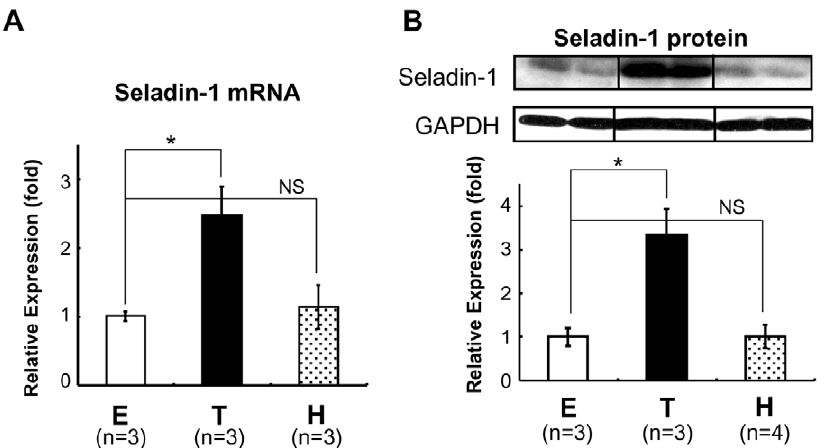
Figure 1. TH induced Seladin-1 mRNA and protein expression in the mouse forebrain. C57/B6 mice (8- to 12-week-old males) were rendered hypothyroid (H) with MMI and PTU diet or treated with T 3 (T). E: euthyroid basal status (control). The number of mice involved in each treatment is indicated in the figures. Forebrain total RNA was isolated and one microgram of total RNA was subjected to reverse transcription (RT). RT real-time PCR analysis for Seladin-1 was performed using mouse forebrain cDNA (A). Relative values (mean 6 S.E.) normalized by cyclophilin A mRNA levels compared with E are shown as relative expression (fold). Western blot analysis using mouse forebrain whole cell extract was performed (B). Representative Western blots for Seladin-1 are shown in the upper panel. Relative optical densities (O.D.) (mean 6 S.E.) normalized by GAPDH levels compared with ‘‘E’’ are shown as relative expression (fold). An asterisk indicates that the difference between the denoted pairs is significant at a confidence level of p , 0.05(*). NS: not significant.